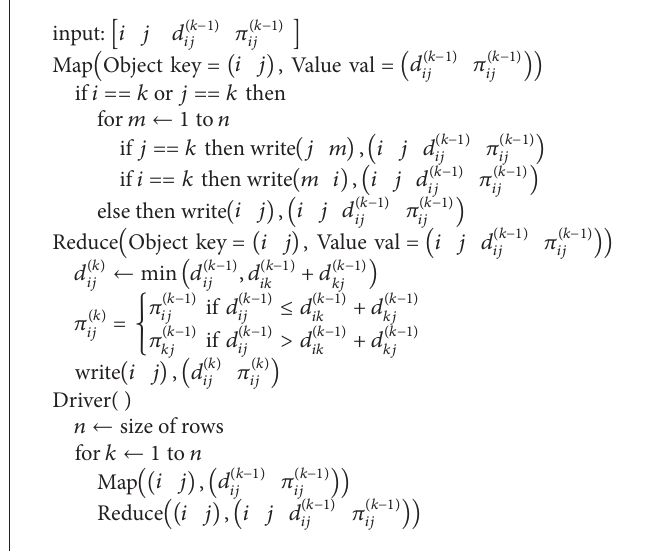
Algorithm 4: MapReduce pseudocode for the all-pairs-shortest-path